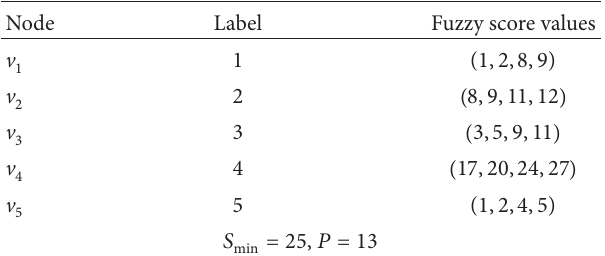
Table 2: The values of node weights (score values).